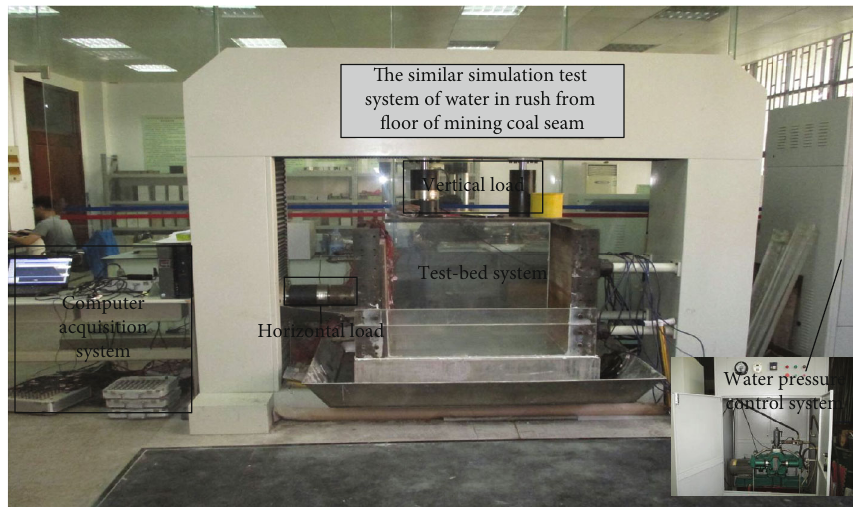
Figure 6: The physical simulation test rig.